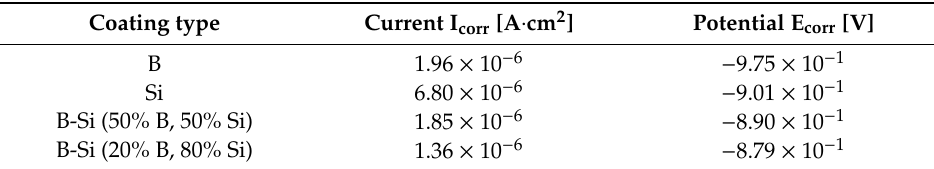
Table 3. Corrosion resistance parameters of B, Si and B-Si